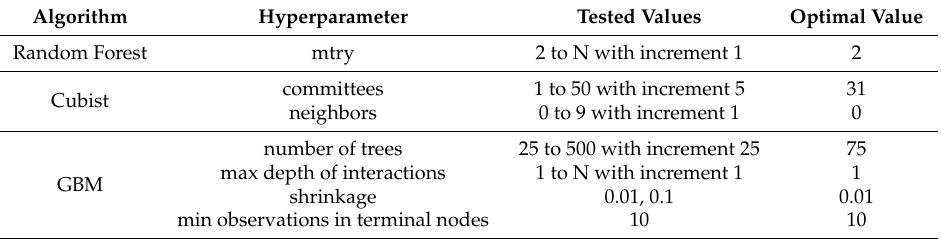
Table 1. Tested values for the hyperparameters of the different prediction models and the optimal parameters revealed during parameter tuning. N is the number of predictor